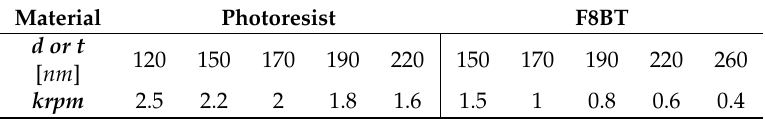
Figure 2. Panels ( a )–( c ) detail the fabrication process of the DFB polymer laser. ( a ) Spin-coat photoresist onto glass substrate. ( b ) Fabricate the grating structure by interference lithography. ( c ) Spin-coat polymer on top of the grating, where t is the gain layer thickness and d is the grating groove depth. ( d ) Photograph of fabricated sample. ( e ) SEM image of the cross-section of the sample showing the photoresist (PR) grating profile and the gain polymer. Table 1. Chart for spin-coating speeds and corresponding structural